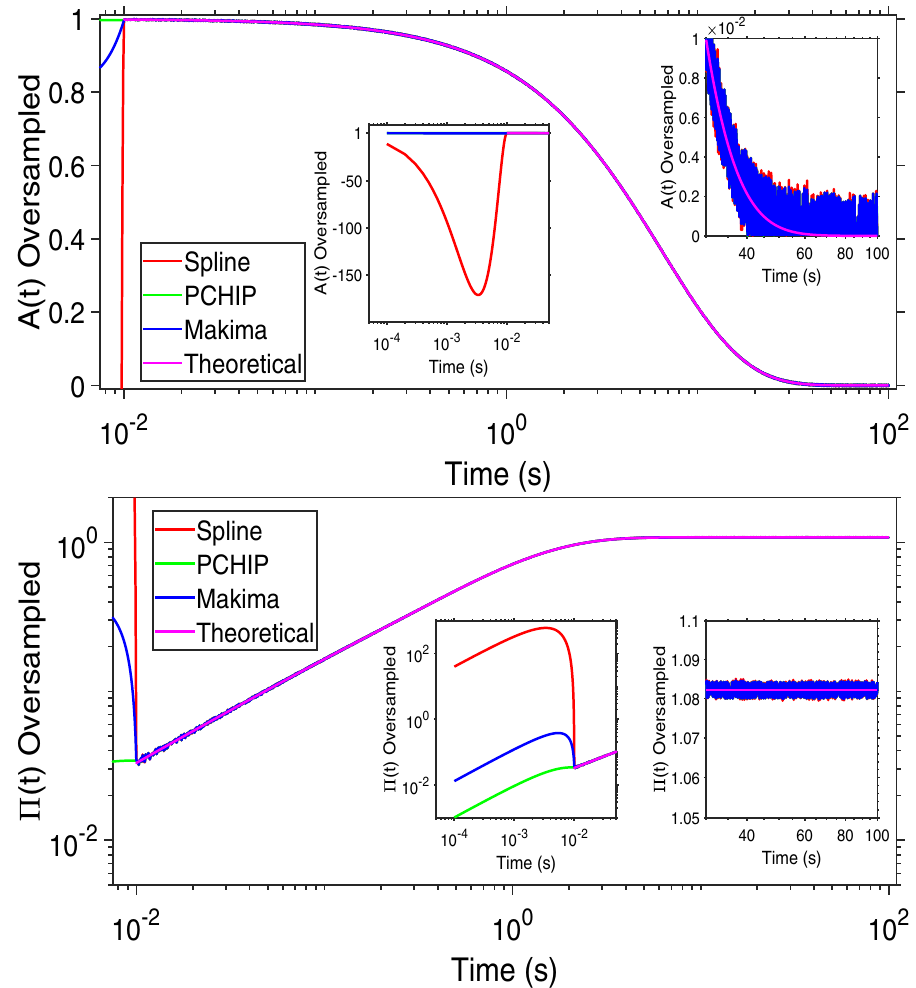
4 experimental points